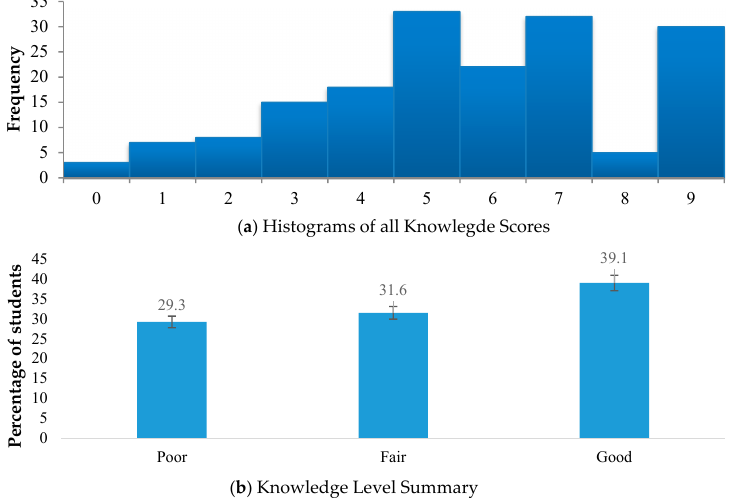
Figure 1. Student Knowledge of Chemical Hazard Warning Signs. Table 2. Descriptive statistics for the knowledge scores by selected demographics.